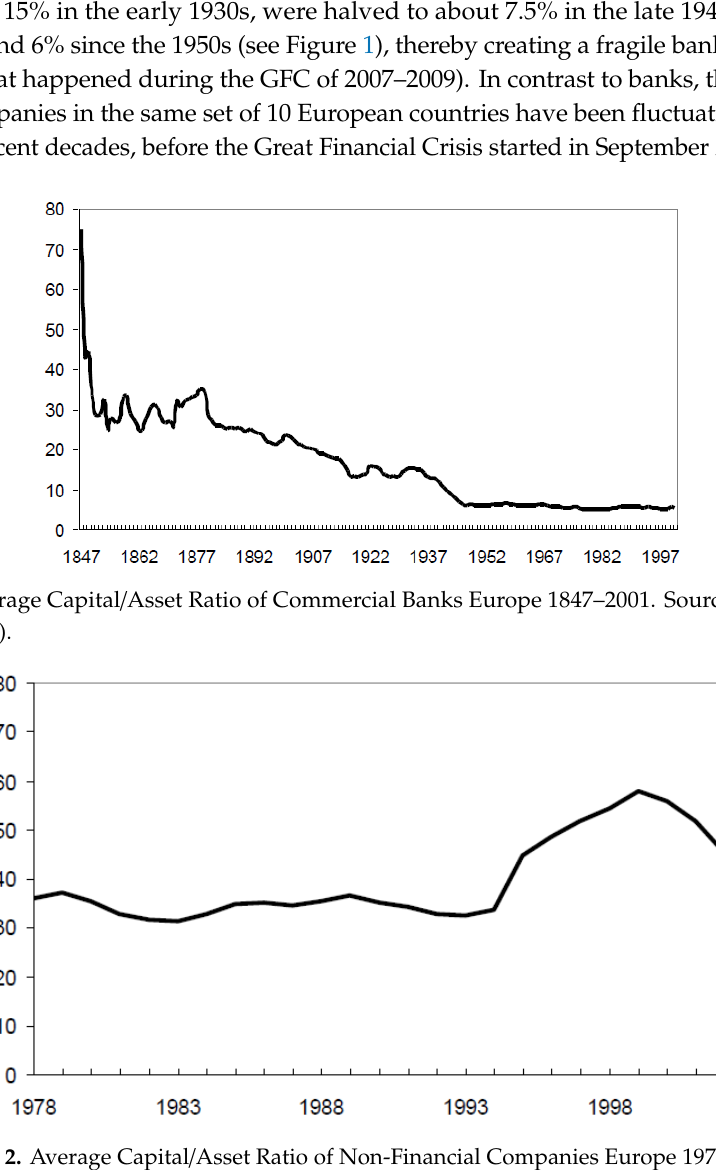
Figure 2. Average Capital/Asset Ratio of Non-Financial Companies Europe 1978–2002.